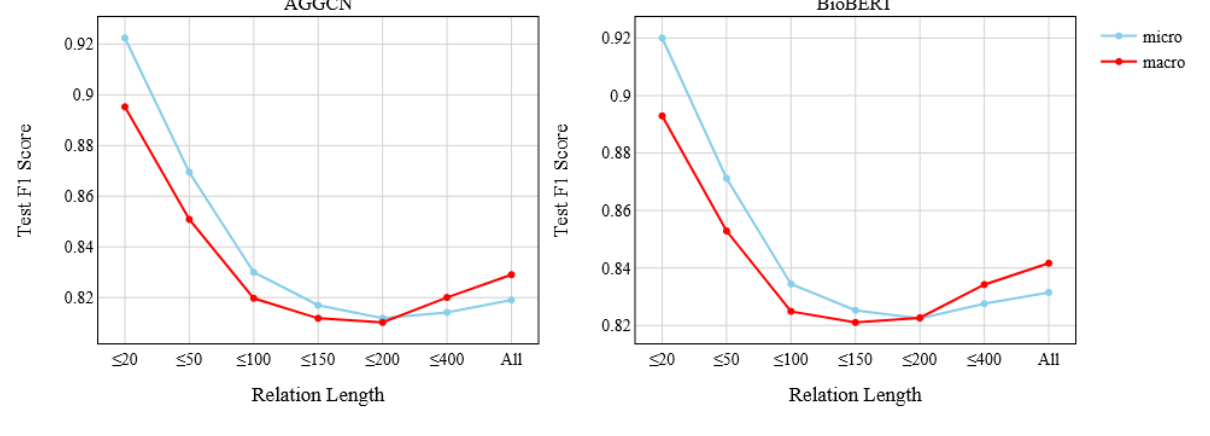
Figure 5. Effect of relation length on model performance. The x-axis indicates the subset range, for example, " ≤ 20" indicates the test subset that consists of all the instances with a relation length of 20 or lower. AGGCN: attention-guided graph convolutional network; BERT: Bidirectional Encoder Representation from Transformers; BioBERT: BERT pretrained on biomedical data.